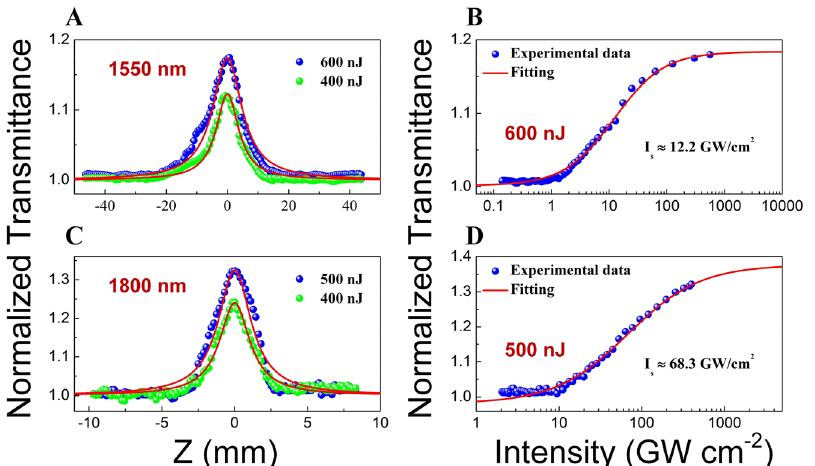
Figure 2: Characterization of the NLO responsesof2DGePnanoflakes.OAZ-scan results at (A) 1550 nm and (C) 1800 nm, respectively. Thenormalizedtransmittance versus input peak intensity at (B) 1550 nm and (D) 1800 nm,